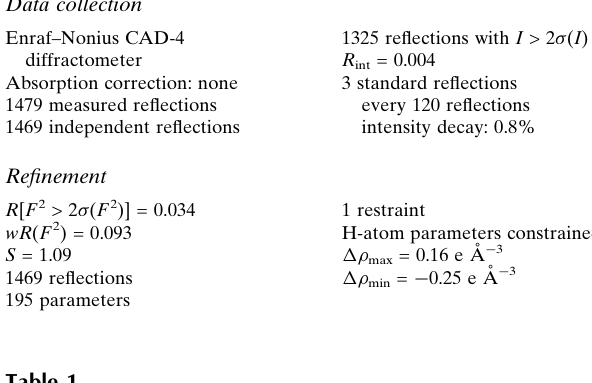
Hydrogen-bond geometry (A˚ , (cid:2)